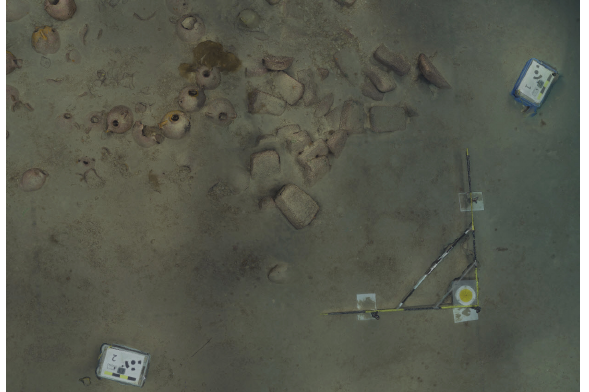
Figure 1: Shooting images: one diver for the camera and two other for the light. Photo: Dave Gration.